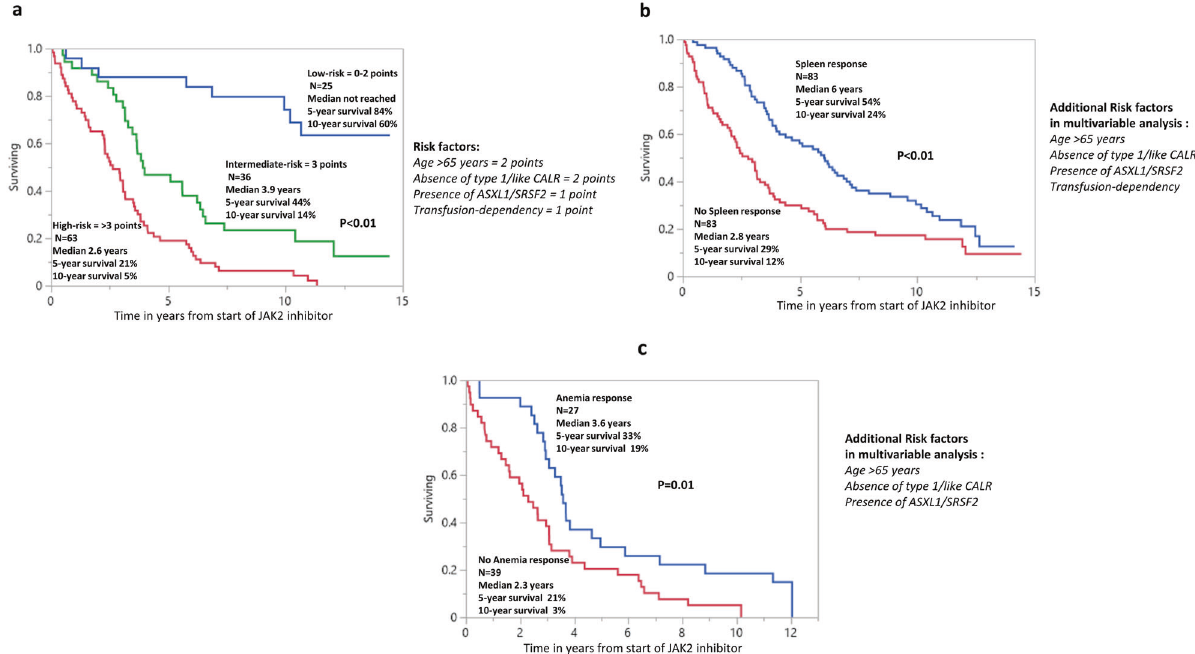
Fig. 2 Post-treatment survival of JAK2 inhibitor-naive patients with myelo fi brosis receiving JAK2 inhibitors in the context of clinical trials and informative for high-risk mutations. a Post-treatment survival of 124 JAK2 inhibitor-naive patients with myelo fi brosis receiving JAK2 inhibitors in the context of clinical trials and informative for high-risk mutations, strati fi ed by HR-weighted scoring system. b Post- treatment survival of 166 JAK2 inhibitor-naive patients with myelo fi brosis receiving JAK2 inhibitors in the context of clinical trials and evaluable for spleen response, strati fi ed by spleen response. c Post-treatment survival of 66 JAK2 inhibitor-naive patients with myelo fi brosis receiving JAK2 inhibitors in the context of clinical trials and transfusion-dependent anemia, strati fi ed by anemia